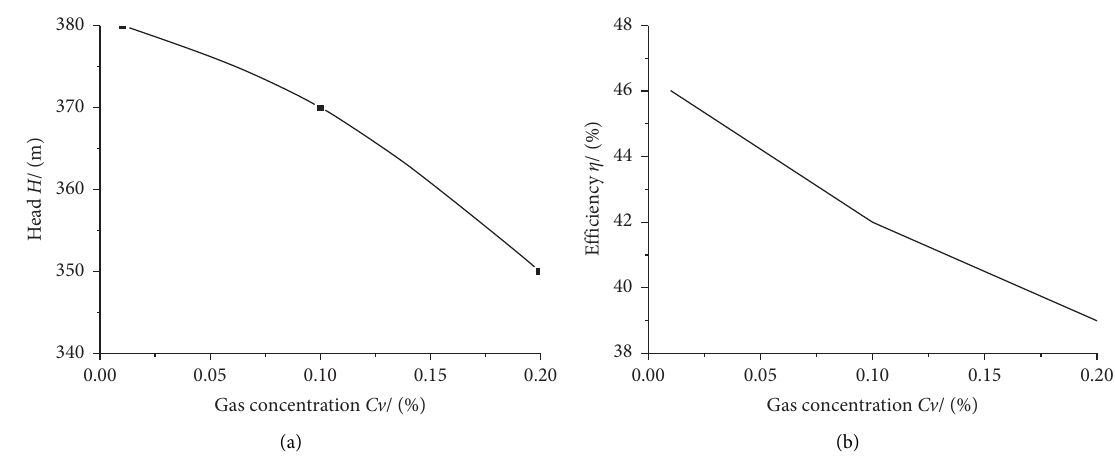
Figure 12: The external characteristics change under different volume fractions. (a) The effect of concentration on the head. (b) The effect of concentration on